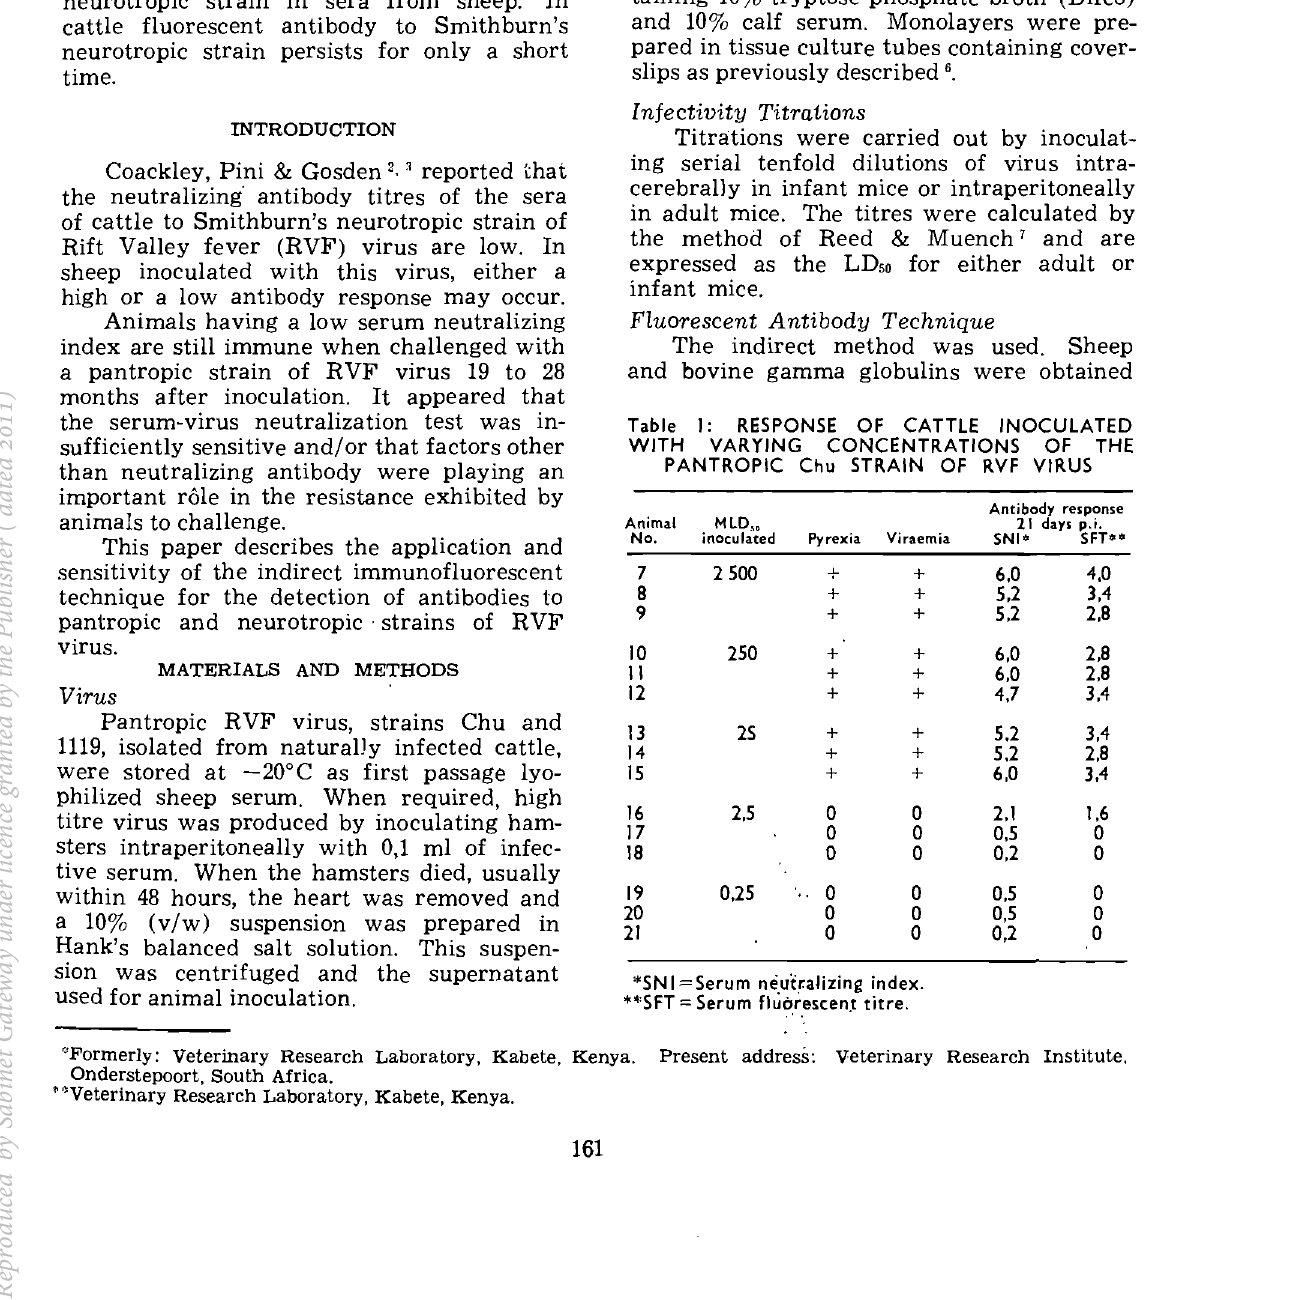
Fluorescent Antibody Technique